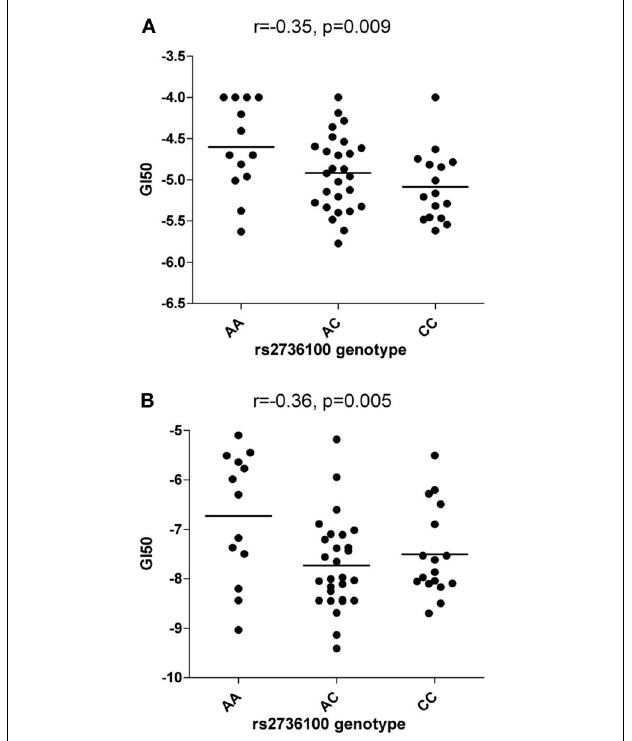
FIGURE 2 | Linear correlation coefficient (r) between rs2736100 and cytotoxicity of 110 anti-cancer drugs grouped in 6 mechanisms of action. The figure showed here that compared to other groups of drugs, the GI50s of anti-mitotics were consistently and negatively correlated with rs2736100 genotype in an additive model (0, 1, and 2 corresponding to AA, AC, and CC), suggesting an association between the C allele and increased sensitivity to